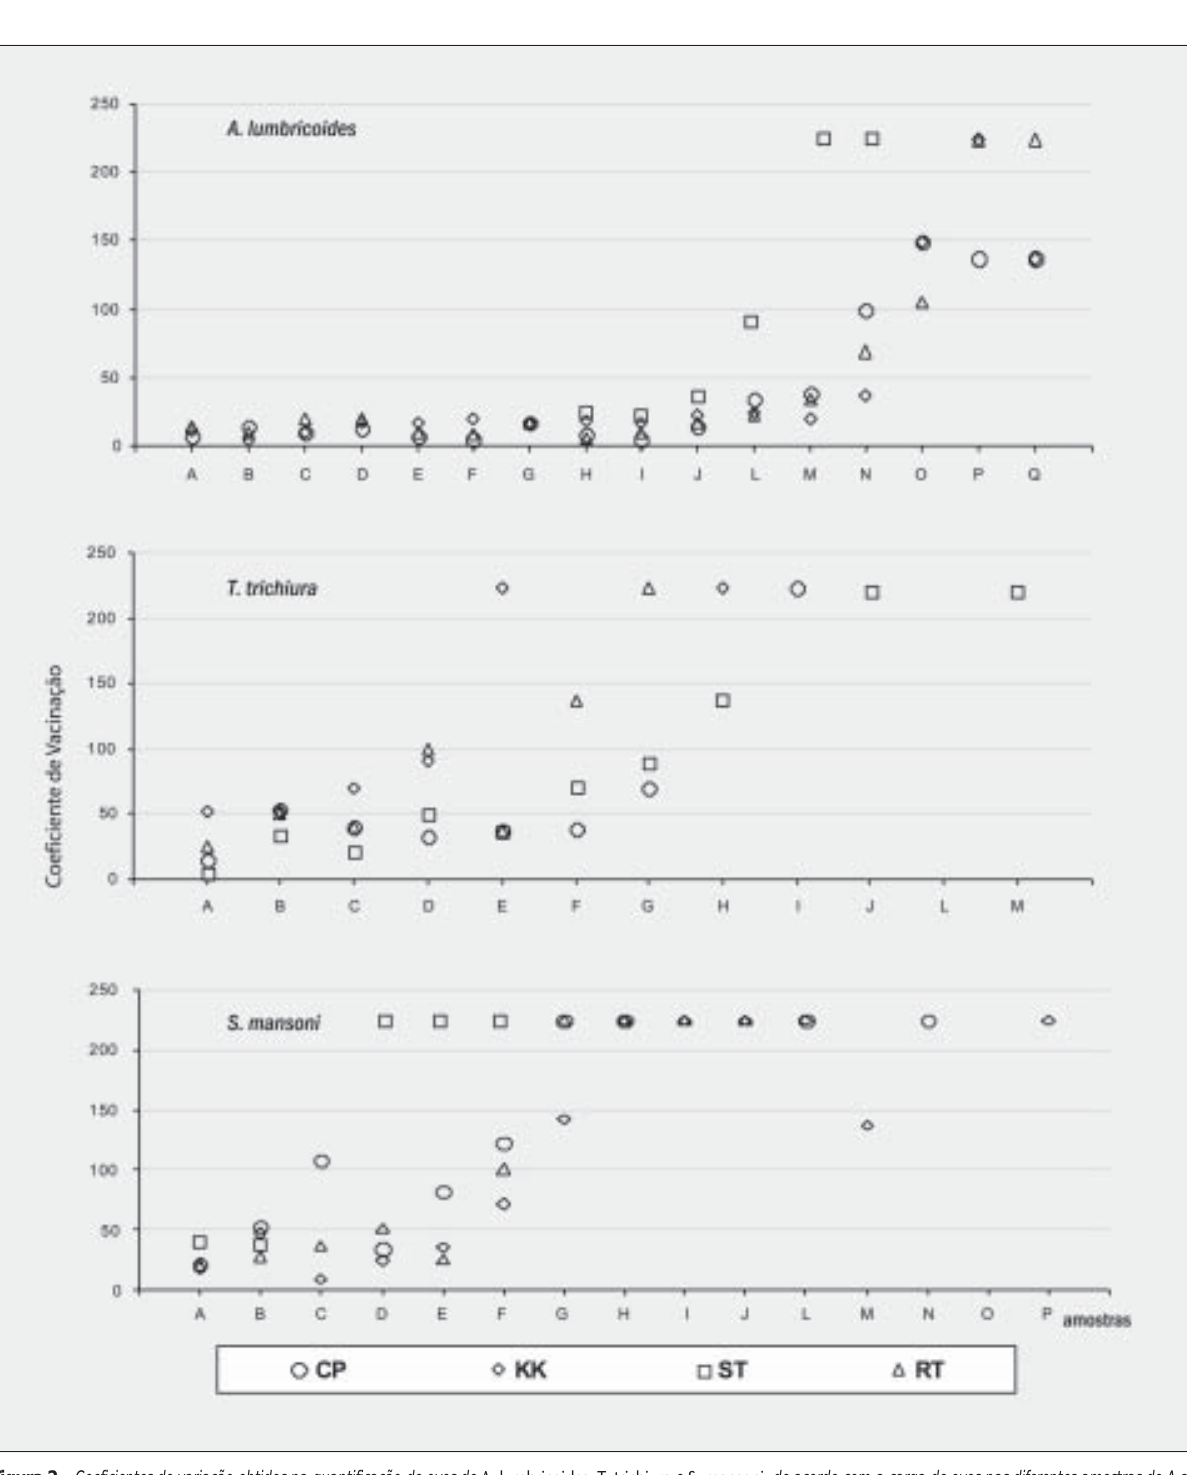
Figura 2 – Coeficientes de variação obtidos na quantificação de ovos de A. lumbricoides, T. trichiura e S. mansoni, de acordo com a carga de ovos nas diferentes amostras de A a Q, preparadas experimentalmente por diluição seriada de razão 2 a partir da amostra A, através da contagem feita em cinco lâminas para cada um dos métodos quantitativos: Coprotest ® quantitativo (CP), Kato-Katz (KK), Stoll & Hausheer (ST) e Ritchie-Knight (RT) carga menor que 1.000opg (amostras C e D, Tabela 1).